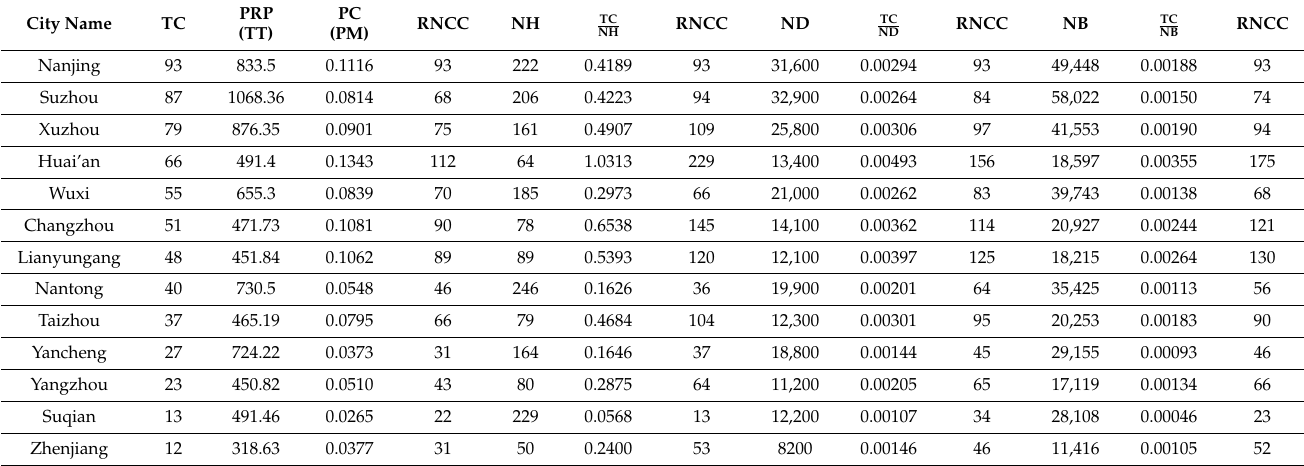
Table 1. Statistics of absolute and relative confirmed diagnoses among the cities in Jiangsu Province on 22 February